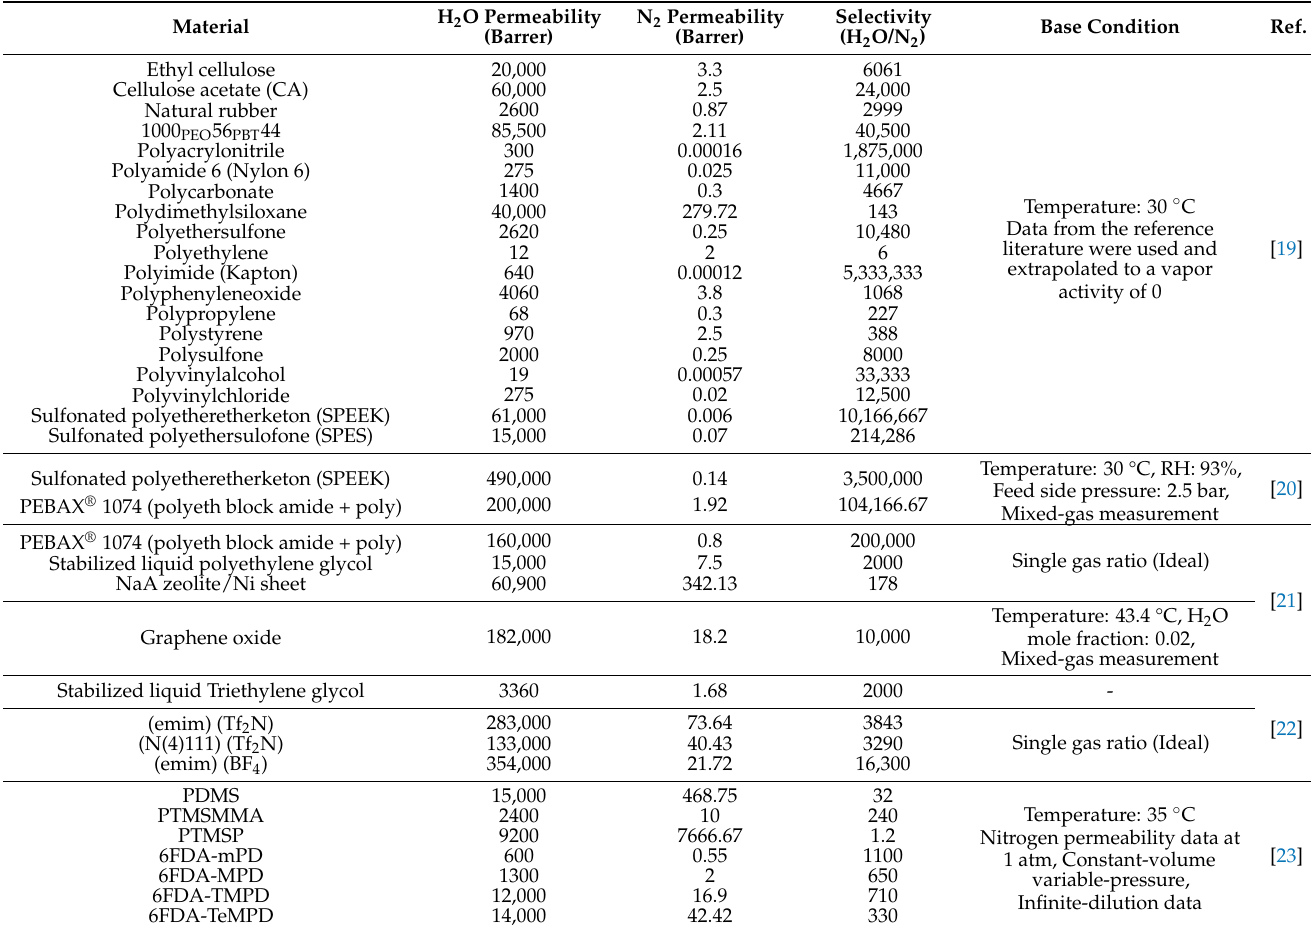
Table 7. H 2 O and N 2 permeability and selectivity data from previous studies of various membrane materials.